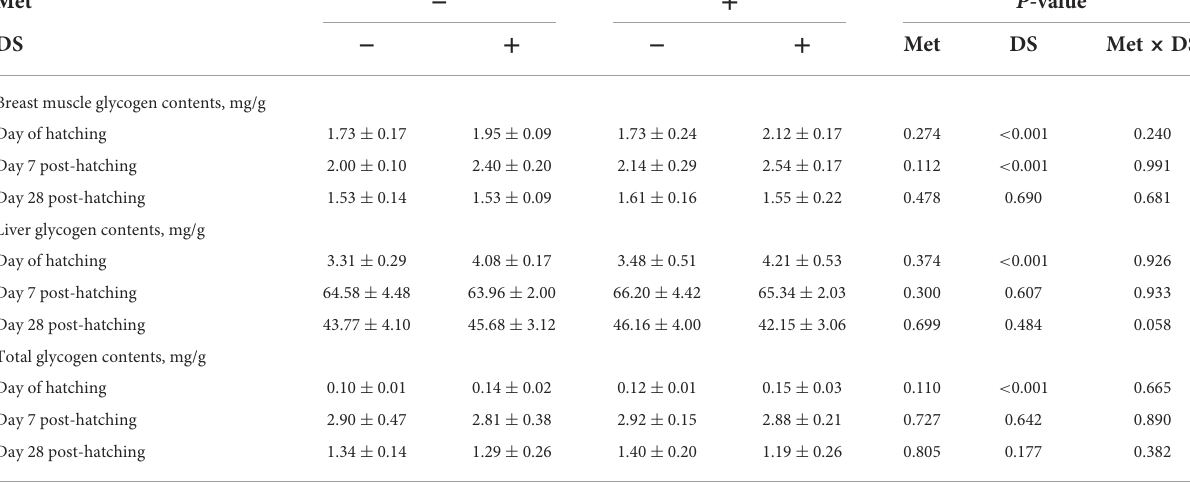
TABLE 5 Effects of in ovo injection of methionine (Met) and disaccharide (DS) on glycogen reserves of geese during the early-life post-hatching a,b .